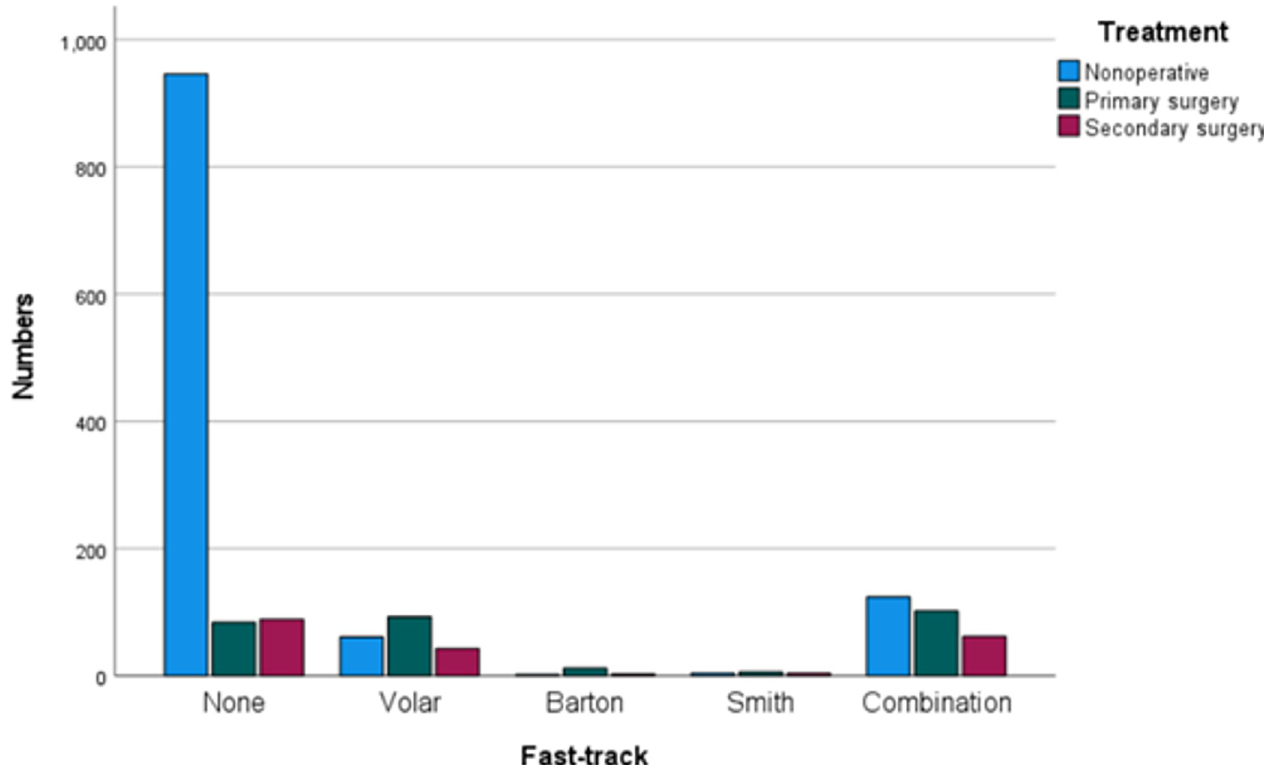
Fig 5. Bar chart depicting differences in treatment depending on fracture type in a retrospective cohort study of 1,635 DRFs in two hospitals in Sweden in 2014–2017. None: Fracture did not fulfill the criteria for any of the categories listed below. Volar: Volar comminution, defined as a free-floating piece of cortex > 3 mm. Barton: Intra-articular volar or dorsal fracture with displacement of the articular surface. Smith: Volar displacement of the distal fragment. Combination: Simultaneous presence of dorsal comminution, severe initial displacement (dorsal angulation > 30˚ or radial inclination < 10˚ or ulnar variance > 3 mm) and suspected physiological osteopenia/osteoporosis.